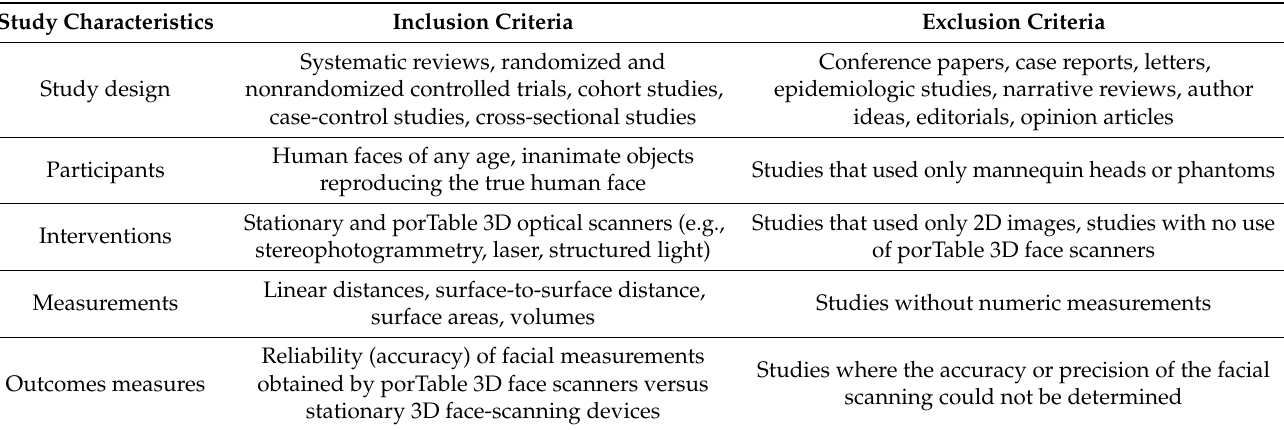
Table 1. Inclusion and exclusion criteria for this